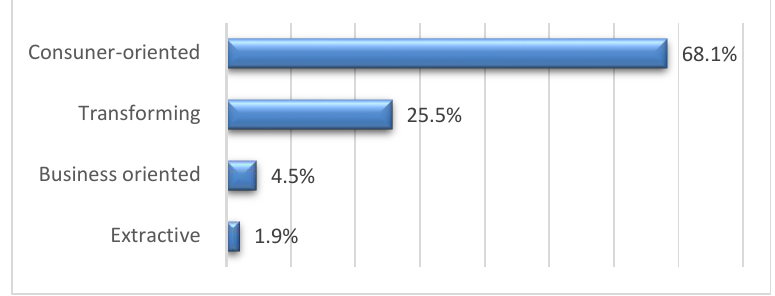
Figure 7: Sector Distribution ; Source: Author